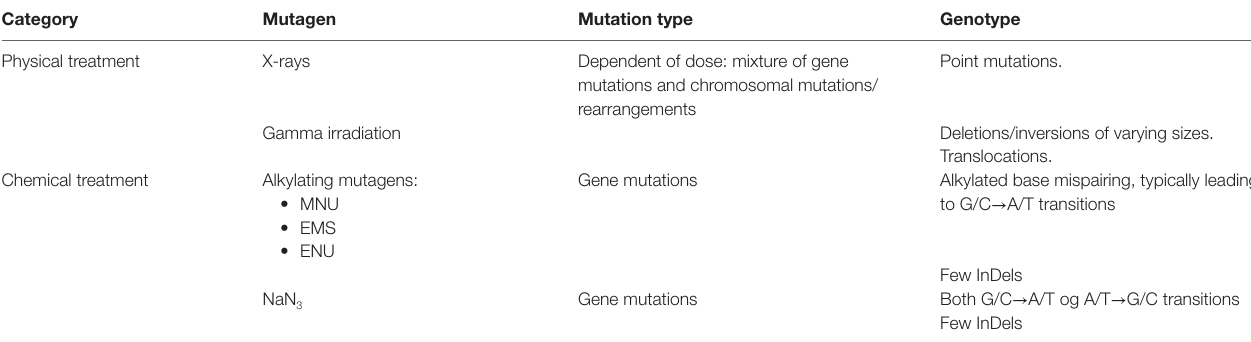
TABLE 1 | Mutagens commonly used in mutation breeding and in generation of TILLING mutant populations (Leitao, 2011; Mba et al., 2011; Sikora et al.,